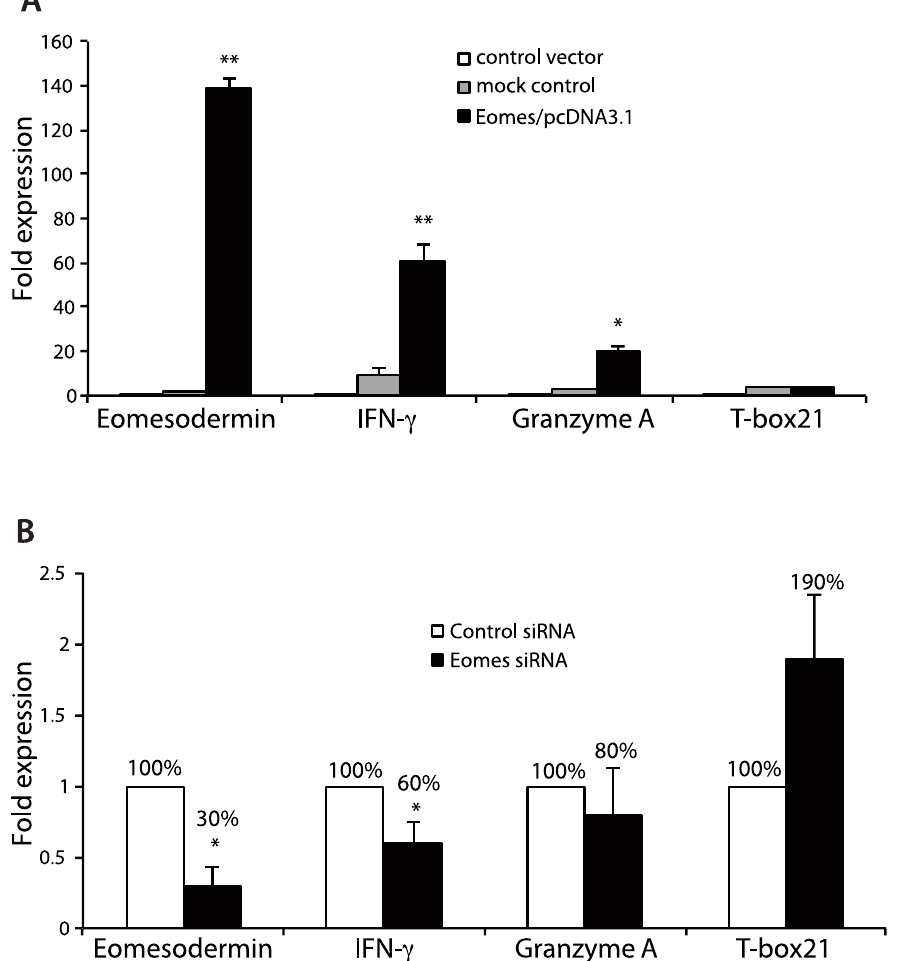
Figure 7. Eomes mediated effects on salmon spleen lymphocytes. Salmon leukocytes were transiently transfected with Eomes/pcDNA3.1 vector or control vector (pmaxGFP vector) ( A ) EomessiRNA or control siRNA ( B ). After 5 h, cells were stimulated with ConA + PHA + recombinant huIL-2. 24 h post stimulation, lymphocytes were sorted by FACS, collected and analyzed for the expression of Eomes, IFN- c , granzymeA, T-box21 and EF-1 a by QPCR. Eomes, IFN- c , granzymeA, T-box21 mRNA expression in cells transfected with control siRNA were set to 100%. Statistical differences ( P , 0.005, and P , 0.0004) between different treatment and control are indicated by asterisks (*, **) above the bars, respectively.